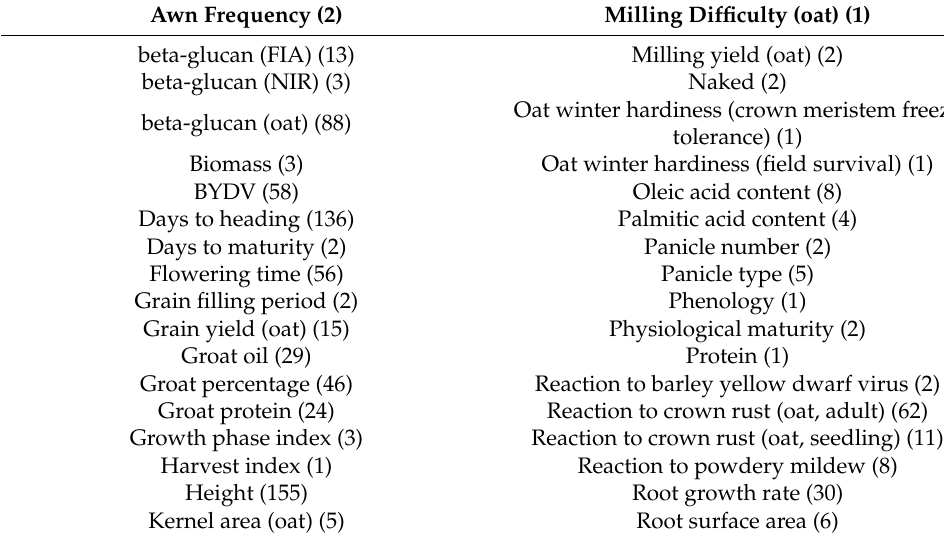
Table 2. Trait Categories with number of Avena QTL in GrainGenes in